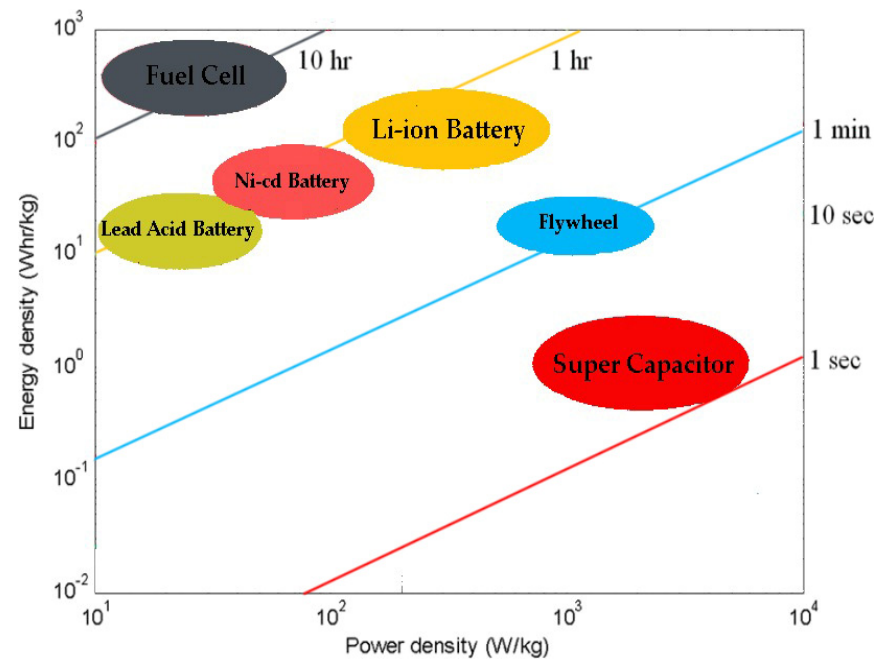
Figure 6. Power density and energy density interconnection of energy storage systems.